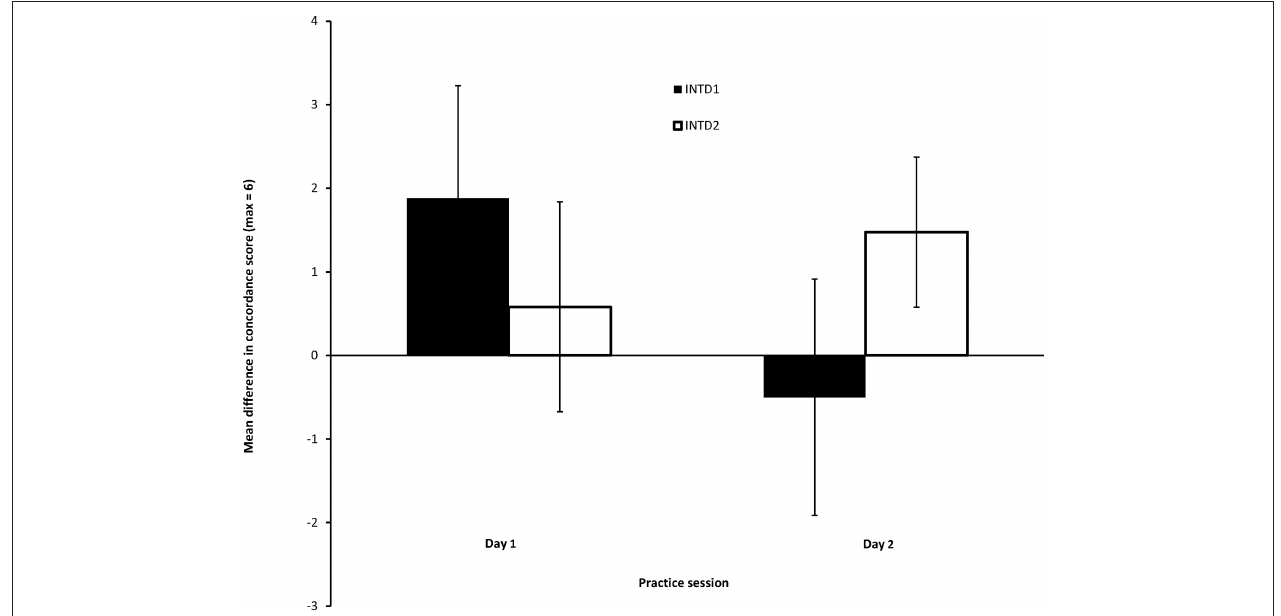
Figure 3 | Mean difference in instruction concordance scores for the two internal instruction groups (inTD1 and inTD2) after day 1 and day 2 of practice.